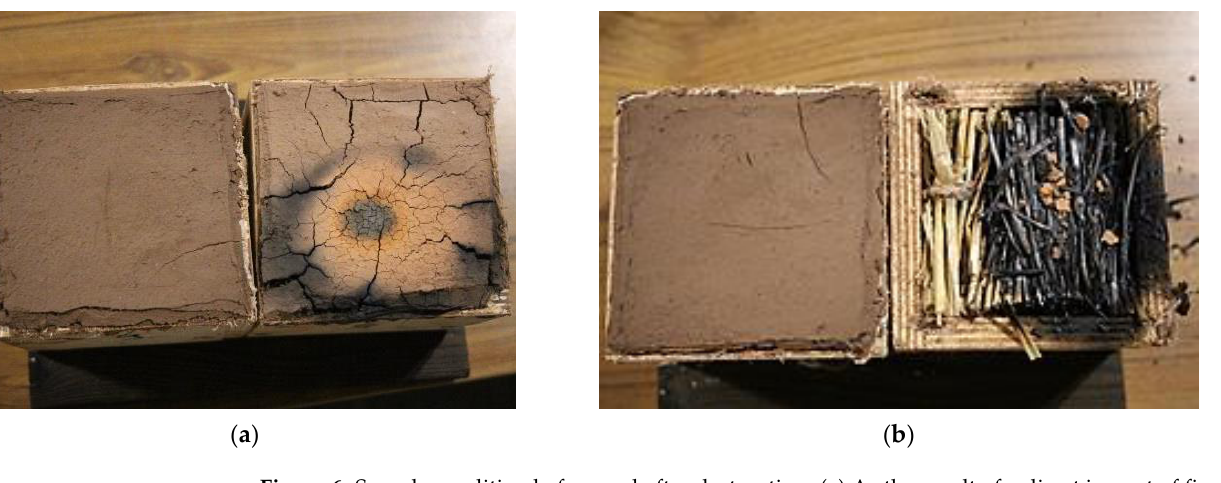
Figure 6. Sample condition before and after destruction: ( a ) As the result of a direct impact of fire of temperature over 1000 °C; ( b ) Charred sample after high-temperature impact test. temperature over 1000 ◦ C; ( b ) Charred sample after high-temperature impact